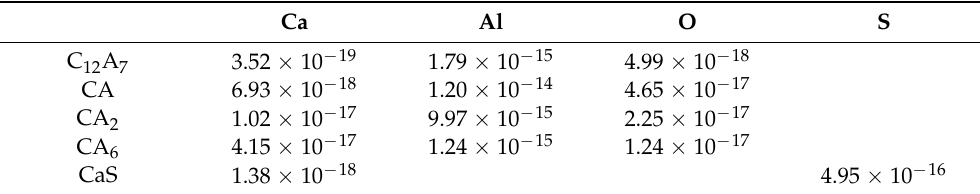
Table 2. The comparison of calculated coarsening rate (m 3 /s) of different CA x and CaS to determine the rate-controlling component, namely, Ca, Al, O, and